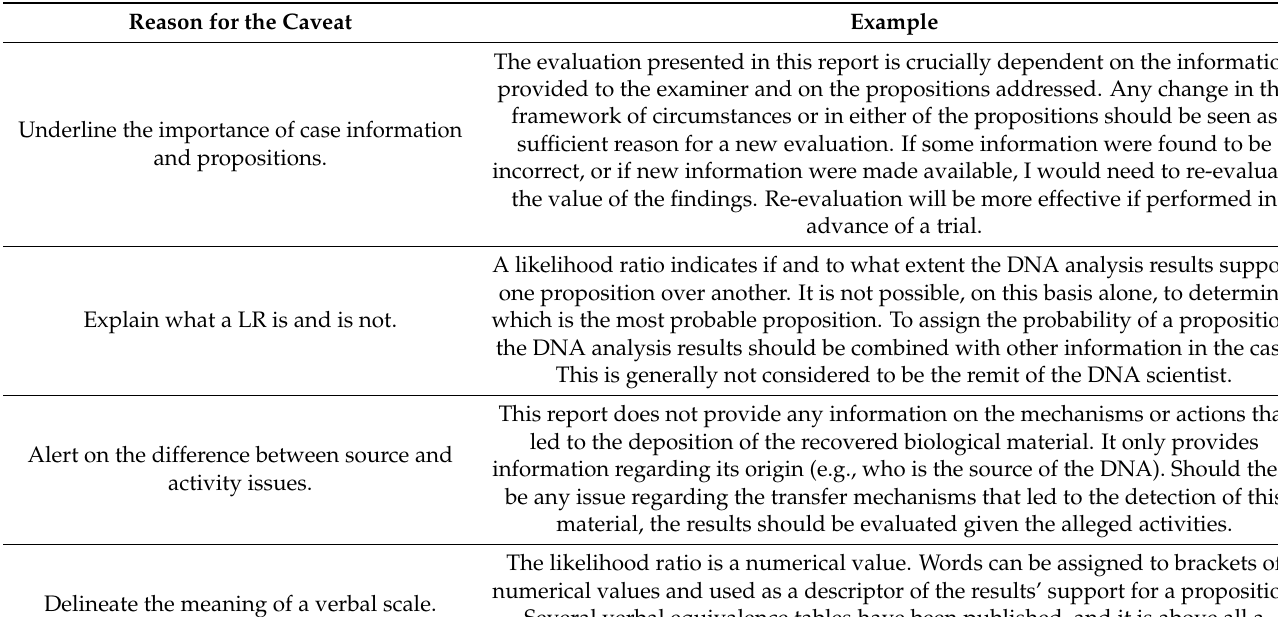
Table 8. Examples of useful caveats in written